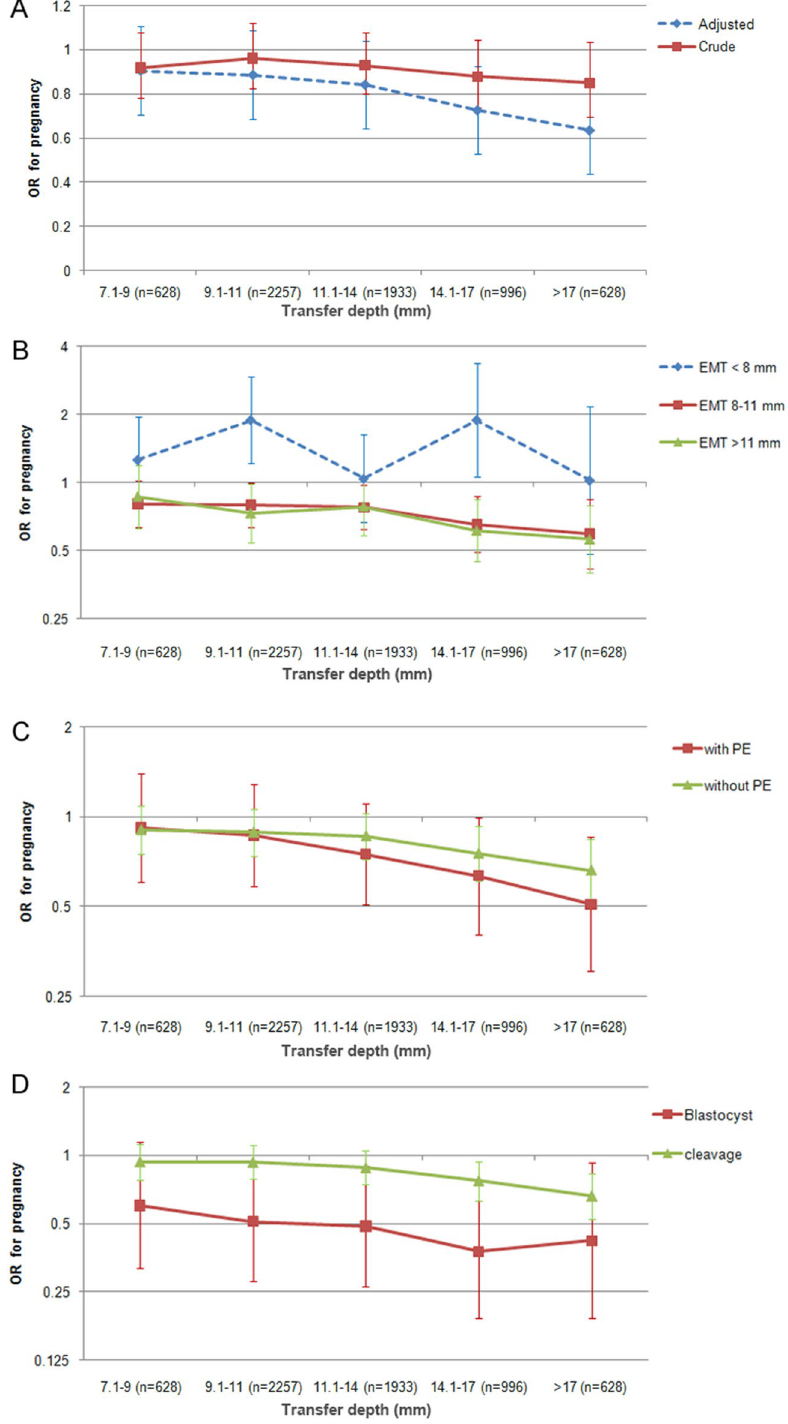
Figure 1. Adjusted ORs (95% CI) for clinical pregnancy adjusted for female`s age, duration of infertility, hydrosalpinx, the number of oocytes retrieved, starting dose of stimulation, type of GnRH analogues, the number of embryos transferred, endometrial thickness, endometrial pattern, progesterone elevation, the development stage of transferred embryos, the presence of at least one good-quality embryo transferred and providers of embryo transfer through different transfer depth levels, using transfer depth ≤ 7 mm (n = 1107) as reference. ( A ) Adjusted and unadjusted ORs for pregnancy. ( B ) Adjusted ORs for pregnancy across endometrial thickness (EMT) categories. ( C ) Adjusted ORs for pregnancy in cycles with and without progesterone elevation (PE) ( D ) Adjusted ORs for pregnancy in cleavage transfer cycles and blastocyst transfer